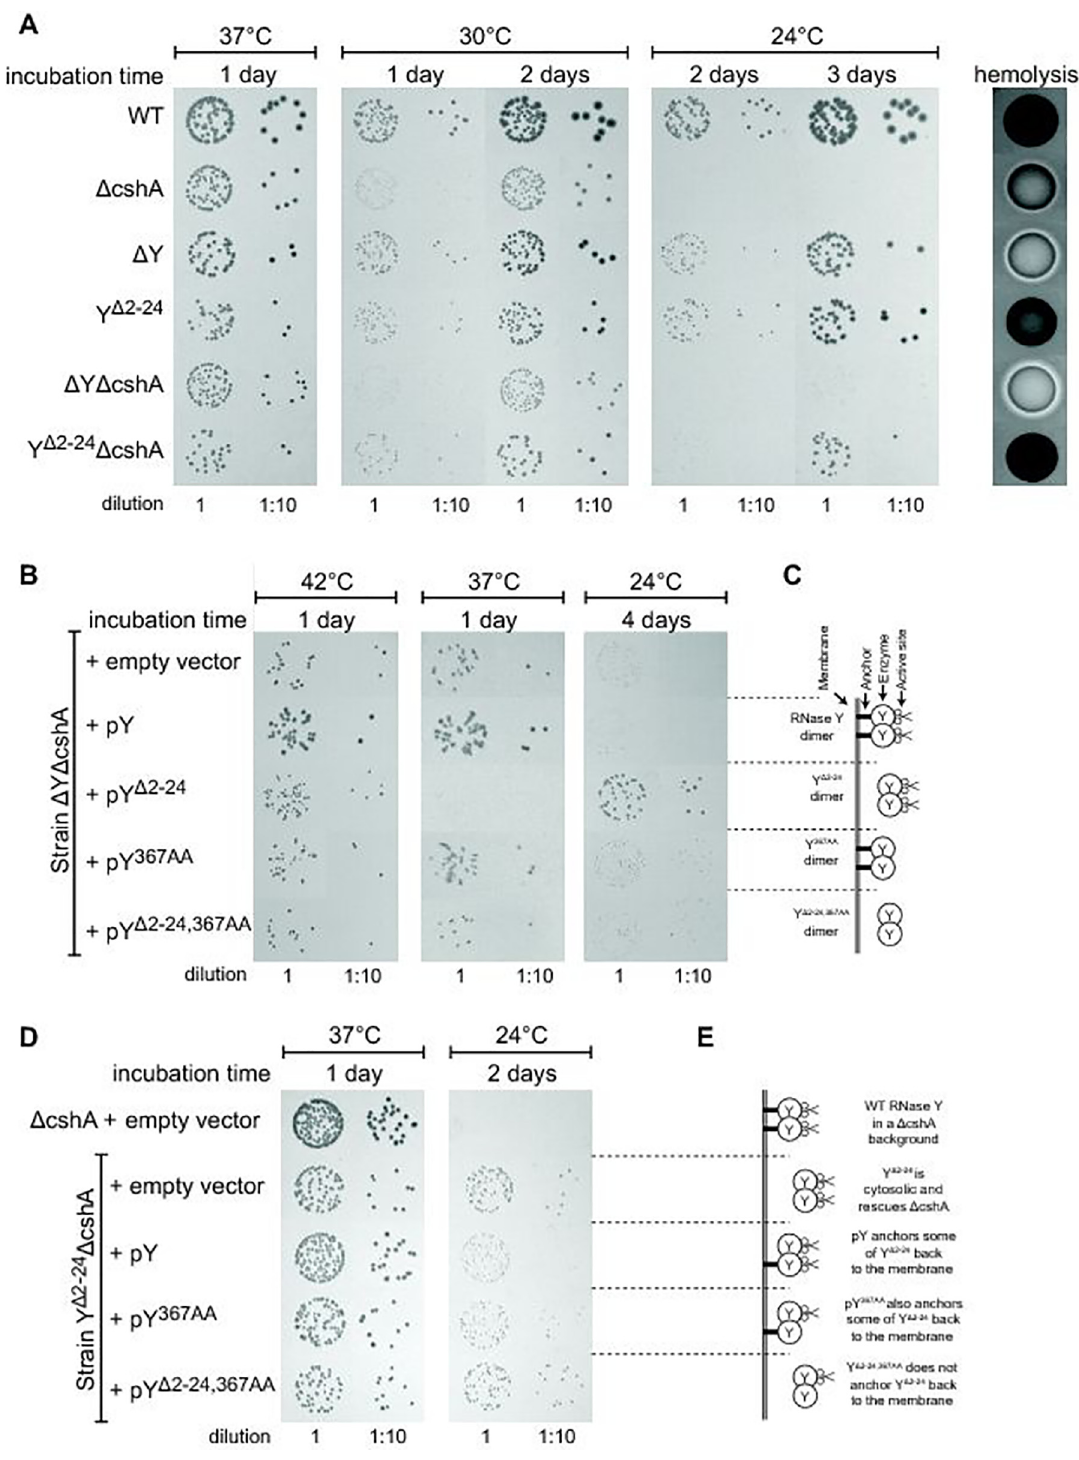
Fig 5. Removal of the membrane anchor enables RNase Y to suppress the phenotypes of a Δ cshA mutant. (A) In the left panel, over-night cultures of single mutants Δ cshA, Δ Y and Y Δ 2 – 24 and double mutants Δ Y Δ cshA and Y Δ 2 – 24 Δ cshA were diluted, spotted on agar-plates, and incubated at the indicated temperatures and times. In the right panel, over-night cultures were spotted on horse-blood-agar. (B) Transformants of strain Δ Y Δ cshA with plasmids expressing variants of RNase Y were selected at 42°C, then restreaked and grown over night at 42°C. Finally the cultures were diluted and spotted at the